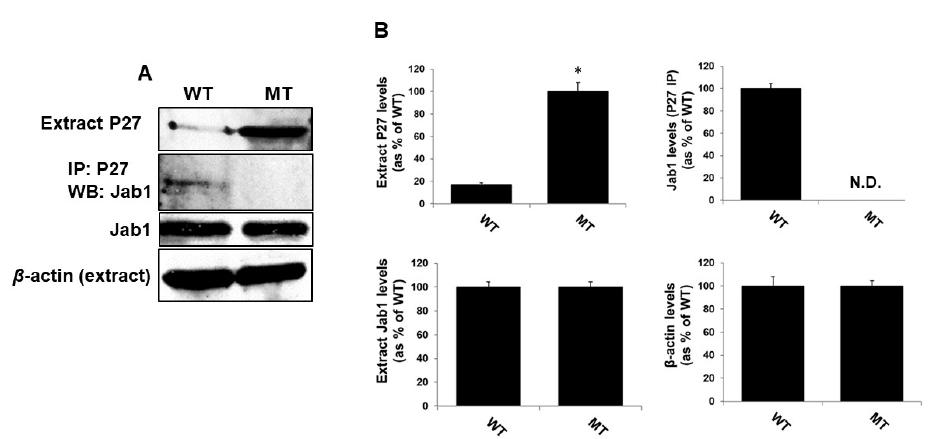
Figure 6. P27 binding to Jab1 and expression is mediated by MsrA. Mouse extracts were made in PBS and in the presence of protease inhibitors cocktail (Sigma-Aldrich, St. Louis, MO, USA) (6 months old mice, n = 3). ( A ) Immunoprecipitation (IP) experiments were performed on brain extracts (500 µ g of protein per extract) using anti-P27 antibody followed by Western blot (WB) analyses using anti-Jab1 antibody as the primary antibody. WB analyses using the specific primary and suitable secondary antibody for each probed protein determined the expression levels of P27, Jab1, and β -actin (loading control). ( B ). Quantification of the each detected protein-band in the Western blot analyses described in Panel A, by using the NIH Image-J program. N.D, not detected; The same extracts used for the experiments performed in Figure 4 were used here. Western blot analysis for determining Jab1 and P27 expression levels in these brain extracts were analyzed using the same gel. Thus, for clarity reasons, the data shown for Jab1 expression in these extracts was duplicated from Figure